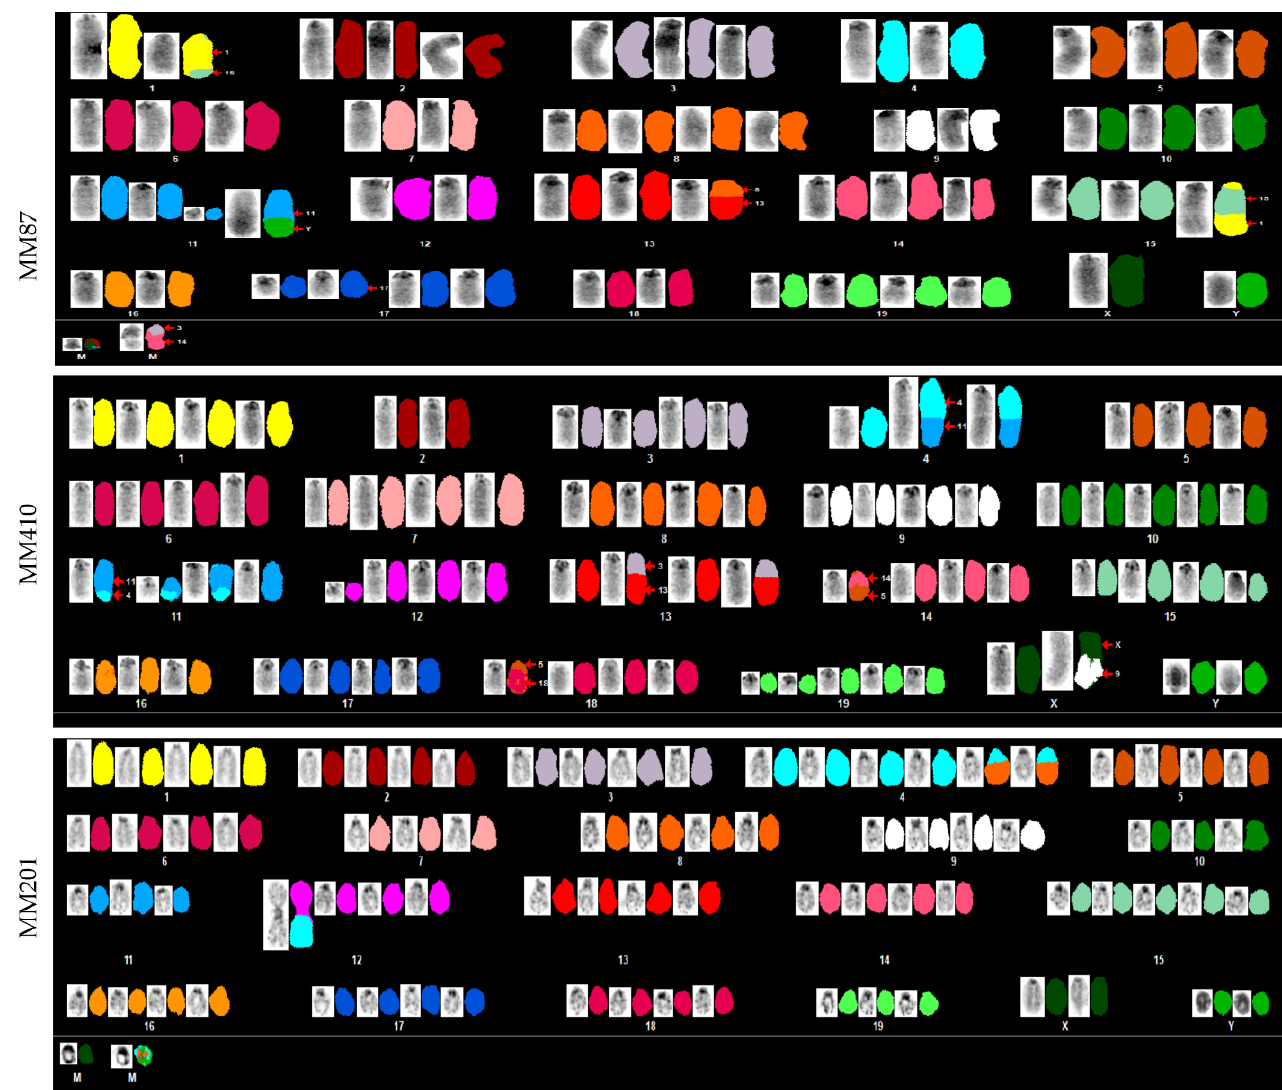
Figure 3. SKY analysis using probes labeled with 21-color mouse SKY paint for each chromosome in MMe cell lines. Representative karyotyping from MM87, MM410, and MM201 cell lines are shown here. Red arrows show examples of translocation. M, marker chromosome too little material for definite characterization.